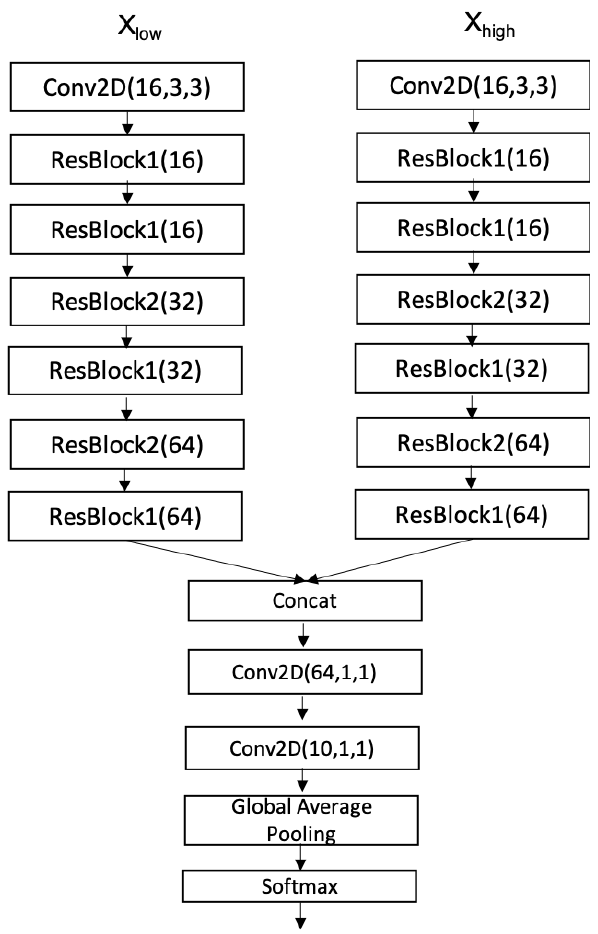
Figure 8. The ResNet baseline. The input is split into independent vectors by the mel frequency bins. The top 50% of the high frequencies form X high , and the remaining mel bins belong to X low . Each vector goes through a 2D convolution before connecting to the chain of residual blocks. Outputs from the chain of residual blocks are concatenated before running though two 2D Convolution operations to produce the output for the